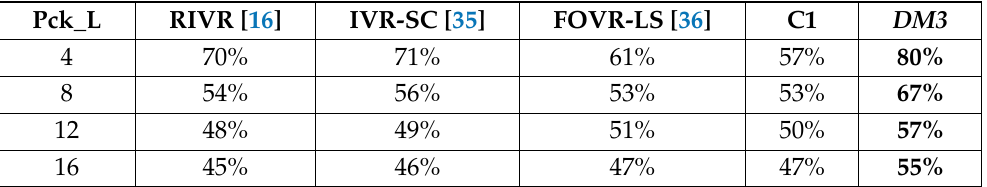
Table 7. Network saturation throughput (%) of virtual-channel (VC) based routers and R-NoC-D for uniform traffic pattern. Pck_L: Packet